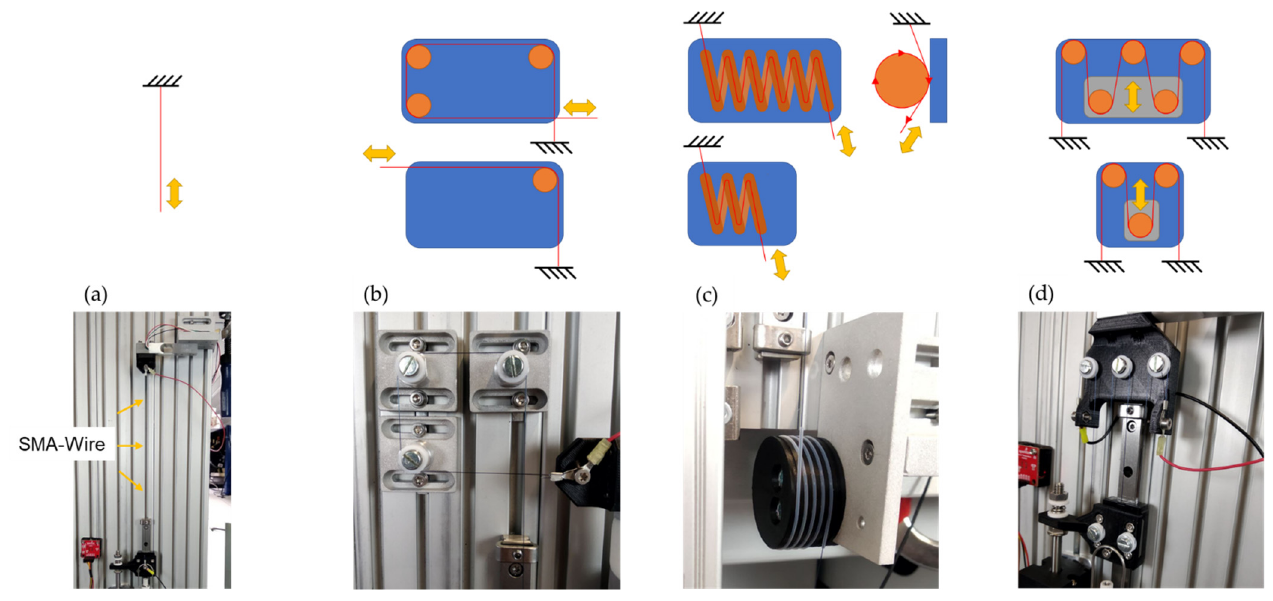
Figure 6. Vertical test rig for pre-tests: ( a ) load cell Sauter CK 6-0P1 (KERN & SOHN GmbH, Balin- gen-Frommern, DE); ( b ) 250 × 0.25 mm SMA wire actuator; ( c ) connecting platform; ( d ) linear po- tentiometer KTC 75 P (Ixthus Instrumentation, Towcester, UK); ( e ) tension spring balance Medio 25 N (PESOLA Präzisionswaagen AG, Schindellegi, CH) to generate the necessary counterforce; and ( f ) temperature sensor TMP117 (SparkFun Electronics, Boulder, CO, USA).